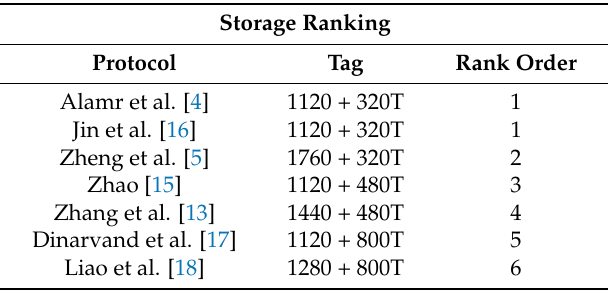
Table 11. Ranking based on reader/server storage of required protocol